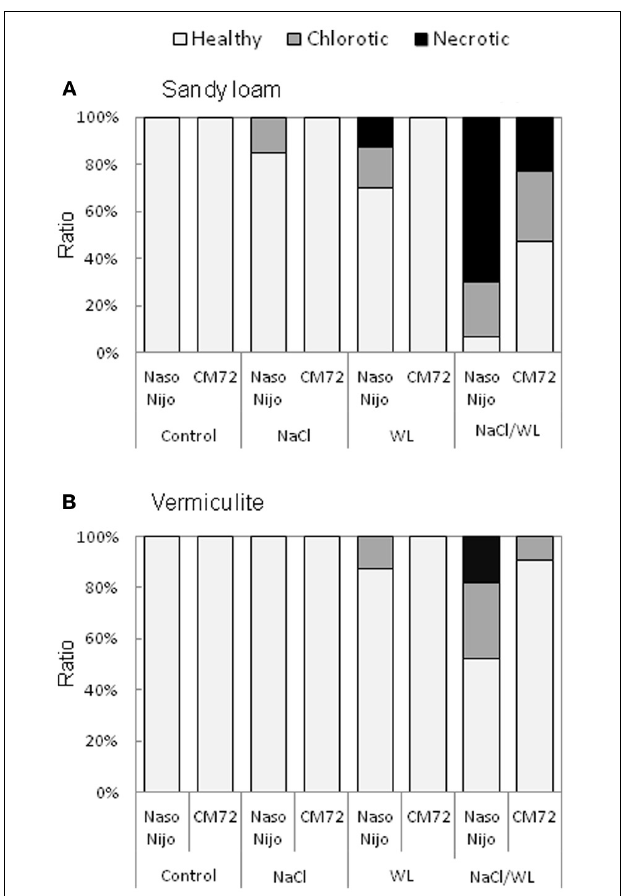
FIGURE 5 | Effects of separate and combined salinity and waterlogging stresses on the ratio of chlorotic and necrotic leaves of two contrasting barley cultivars. Ratio of chlorotic and necrotic leaves were calculated according to the numbers of total, chlorotic and necrotic leaves on plants grown in sandy loam (A) and vermiculite (B) 14 days after the onset of treatment (dark bars, Naso Nijo; light bars, CM72). For growth conditions, details of treatments, and media composition, refer to the Materials and Methods section. Mean ± SD ( n =